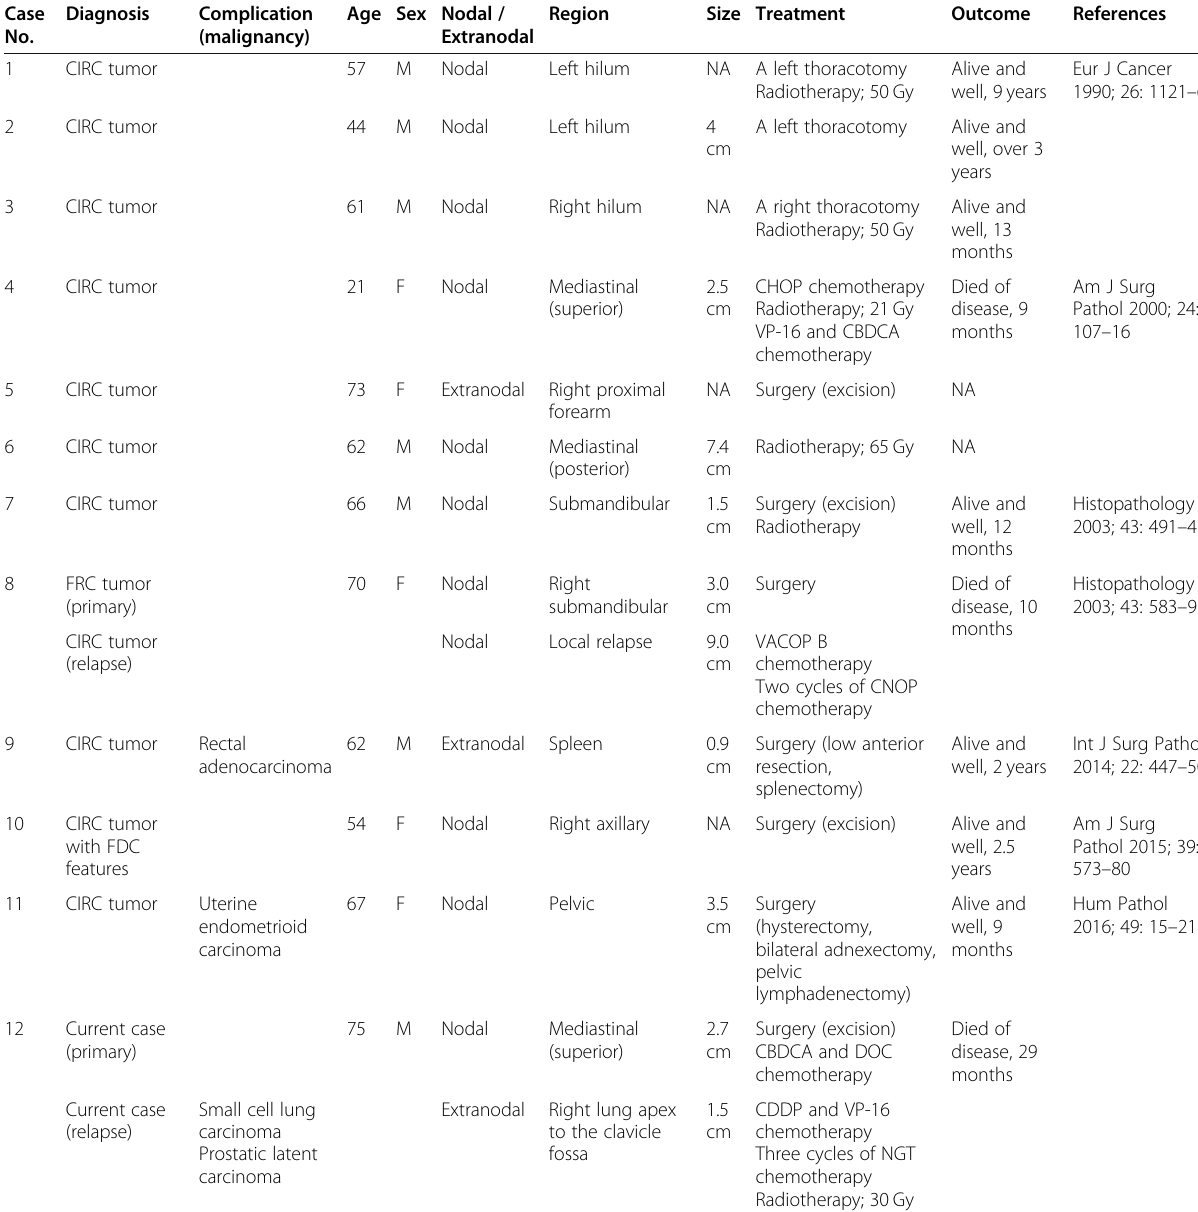
Table 2 Clinical data of published CIRC tumors Case